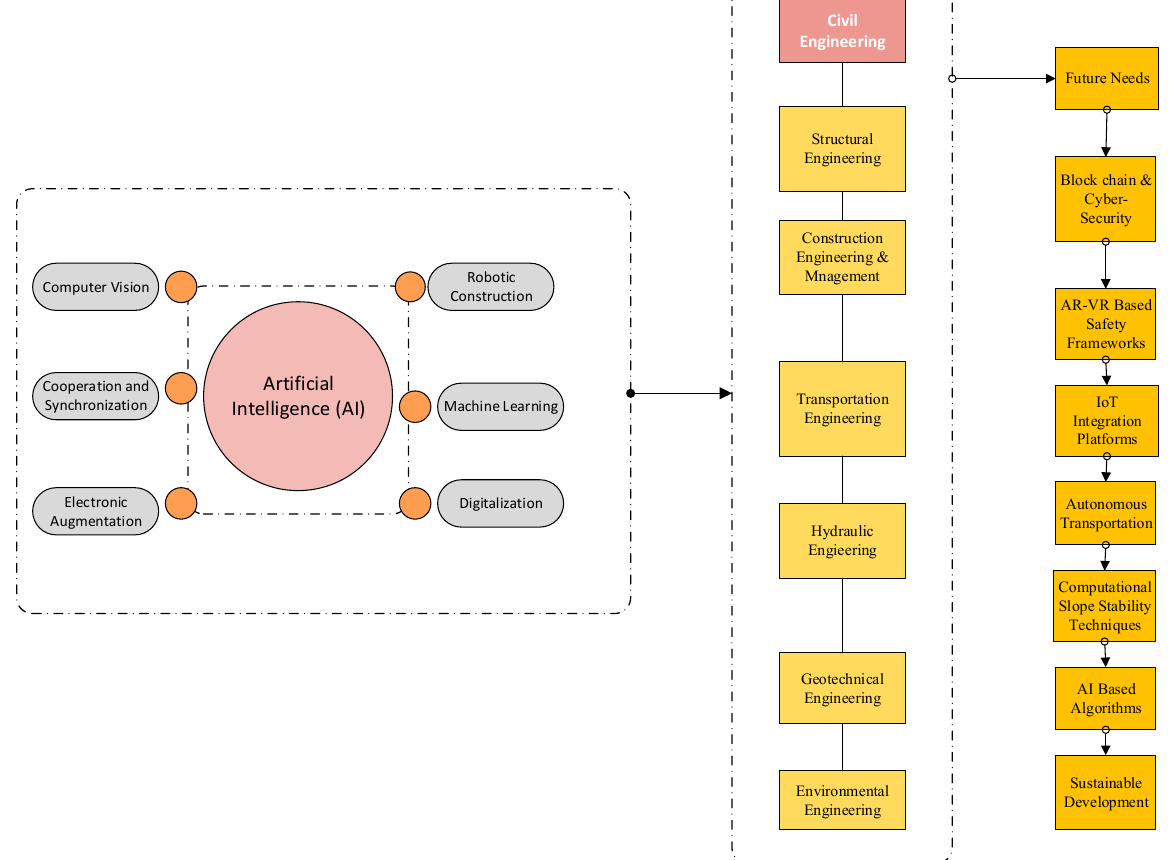
Figure 4. Theoretical framework .